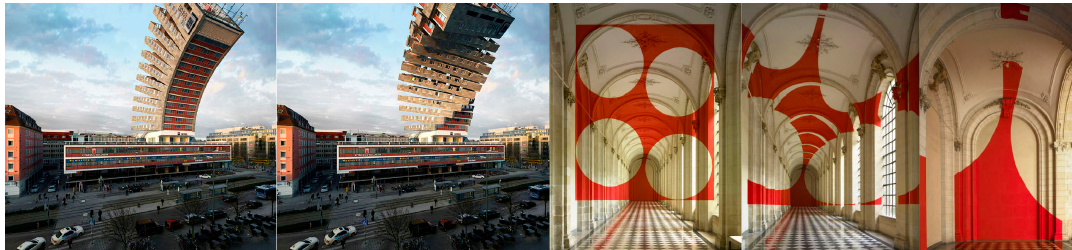
Figure 3. Images that intentionally alter the perceived reality (photographic manipulations) and images that derive from the deception or alteration of the perceptive patterns (anamorphic representations and disparitory